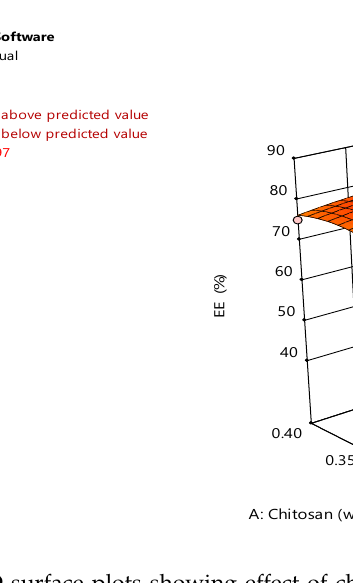
Figure 2. 3D surface plots showing effect of chitosan and tween 80 concentration on the EE of TBN-CSNP.